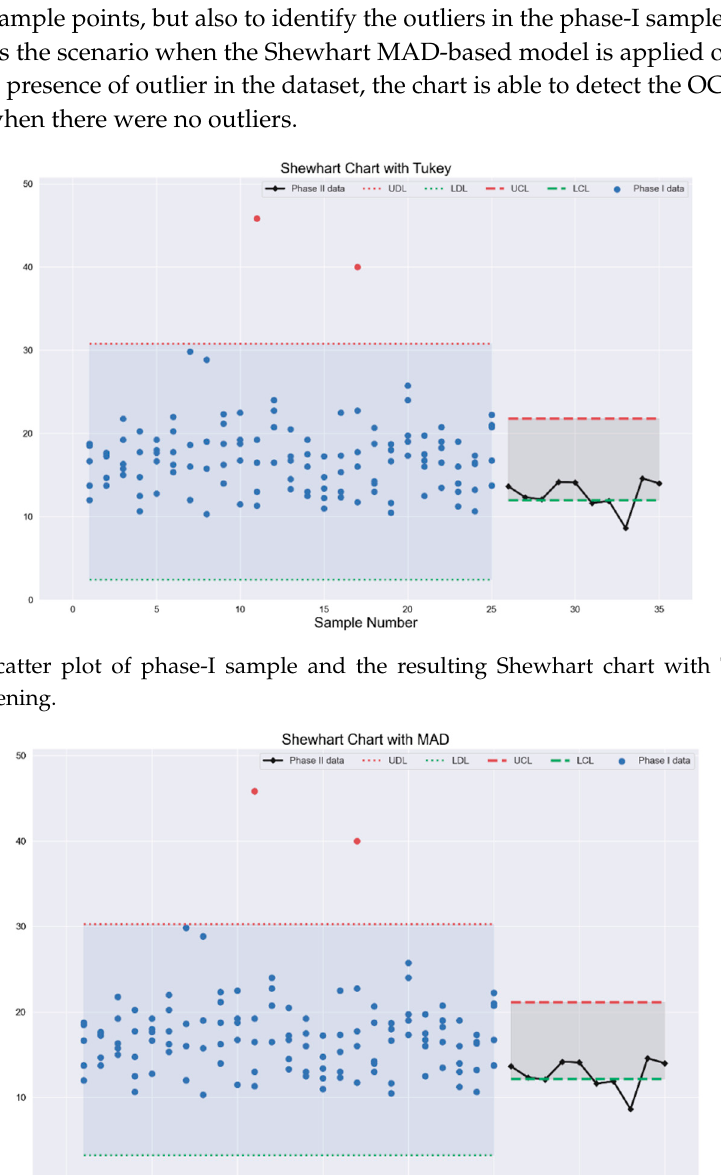
Figure 9. Scatter plot of phase-I sample and the resulting Shewhart chart with estimated parameters and 5% of outliers with magnitude 3.